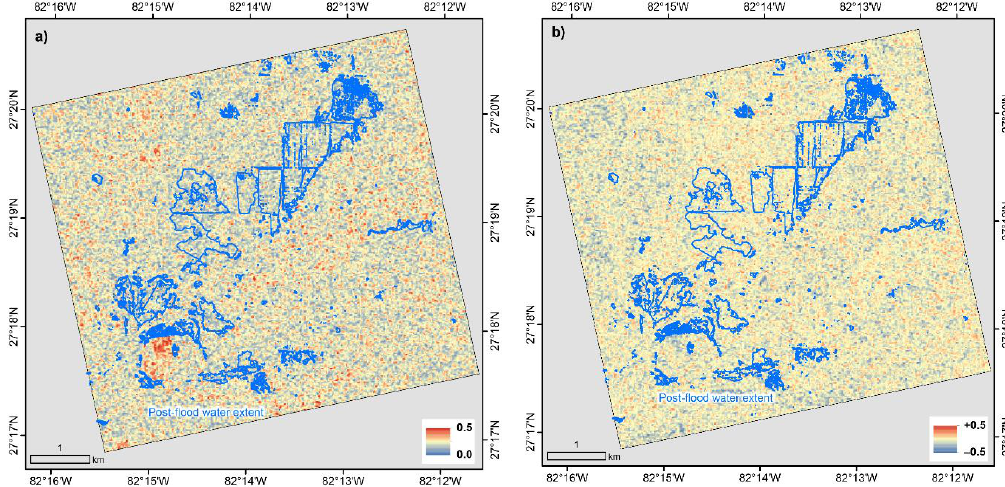
Figure 7. PALSAR-2 imagery of ( a ) coherence between post-flood (12 September 2017) and pre-flood (30 August 2016) scenes and ( b ) coherence decrease between the pre – post pair and two pre-flood scenes (30 August 2016 and 19 January 2016).